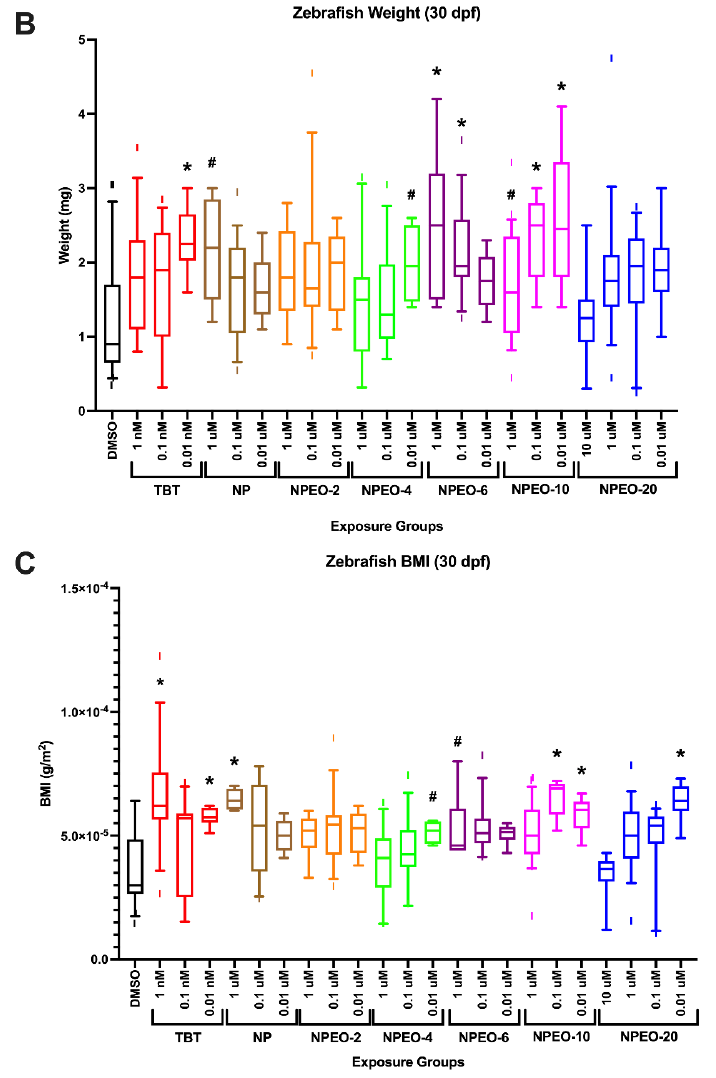
Figure 4. Growth trajectories in zebrafish developmentally exposed to nonylphenol and polyethox- ylates. Zebrafish were developmentally exposed to control chemicals, nonylphenol, or nonylphenol polyethoxylates; aged to 30 days post − fertilization; then measured and stained with Nile Red (0.5 µ g/mL) for 30 min. Zebrafish were imaged and standard length of each fish was measured ( A ) using the integrated point − to − point measurement tool within the Leica software, which scales by magnification. Following imaging, zebrafish were blotted with kim wipes and weighed on a microbalance to obtain total body weights ( B ) for each fish and then averaged across test chemi- cals and concentrations. Zebrafish body mass index ( C ) was calculated by dividing the calculated standard length and weights and correcting measurement units to g/m 2 . n = 24 (DMSO), 16, 21, 25, 15, 20, 24, 14, 21, 25, 15, 25, 27, 22, 28, 25, 22, 27, 26, 25, 23, 26, and 25 across four spawning events (biological replicates) for exposure groups listed below, respectively. * indicates significant increase in total body fluorescence quantification over vehicle control fish, p < 0.05, as per Kruskal–Wallis test with Dunn’s multiple comparisons. DMSO = dimethylsulfoxide, vehicle control; TBT = tributyltin chloride; NPEO = nonylphenol polyethoxylated (with varying average ethoxylate chain lengths). # represents p < 0.10, as per statistics described above. Box and whisker plots depict the following metrics: whiskers represent 10–90th percentiles, box bounds represent the 25th to 75th percentiles, and the middle line represents the